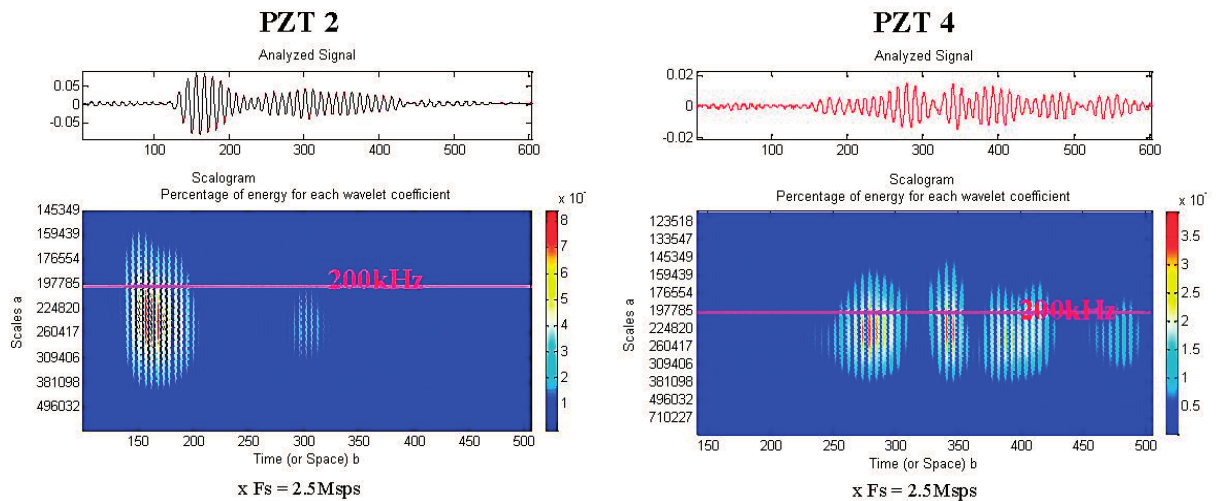
Figure 18. Time-frequency analysis: Notice the difference between the signature of PZT 4 and PZT 2. The delamination area seems to act as a passive